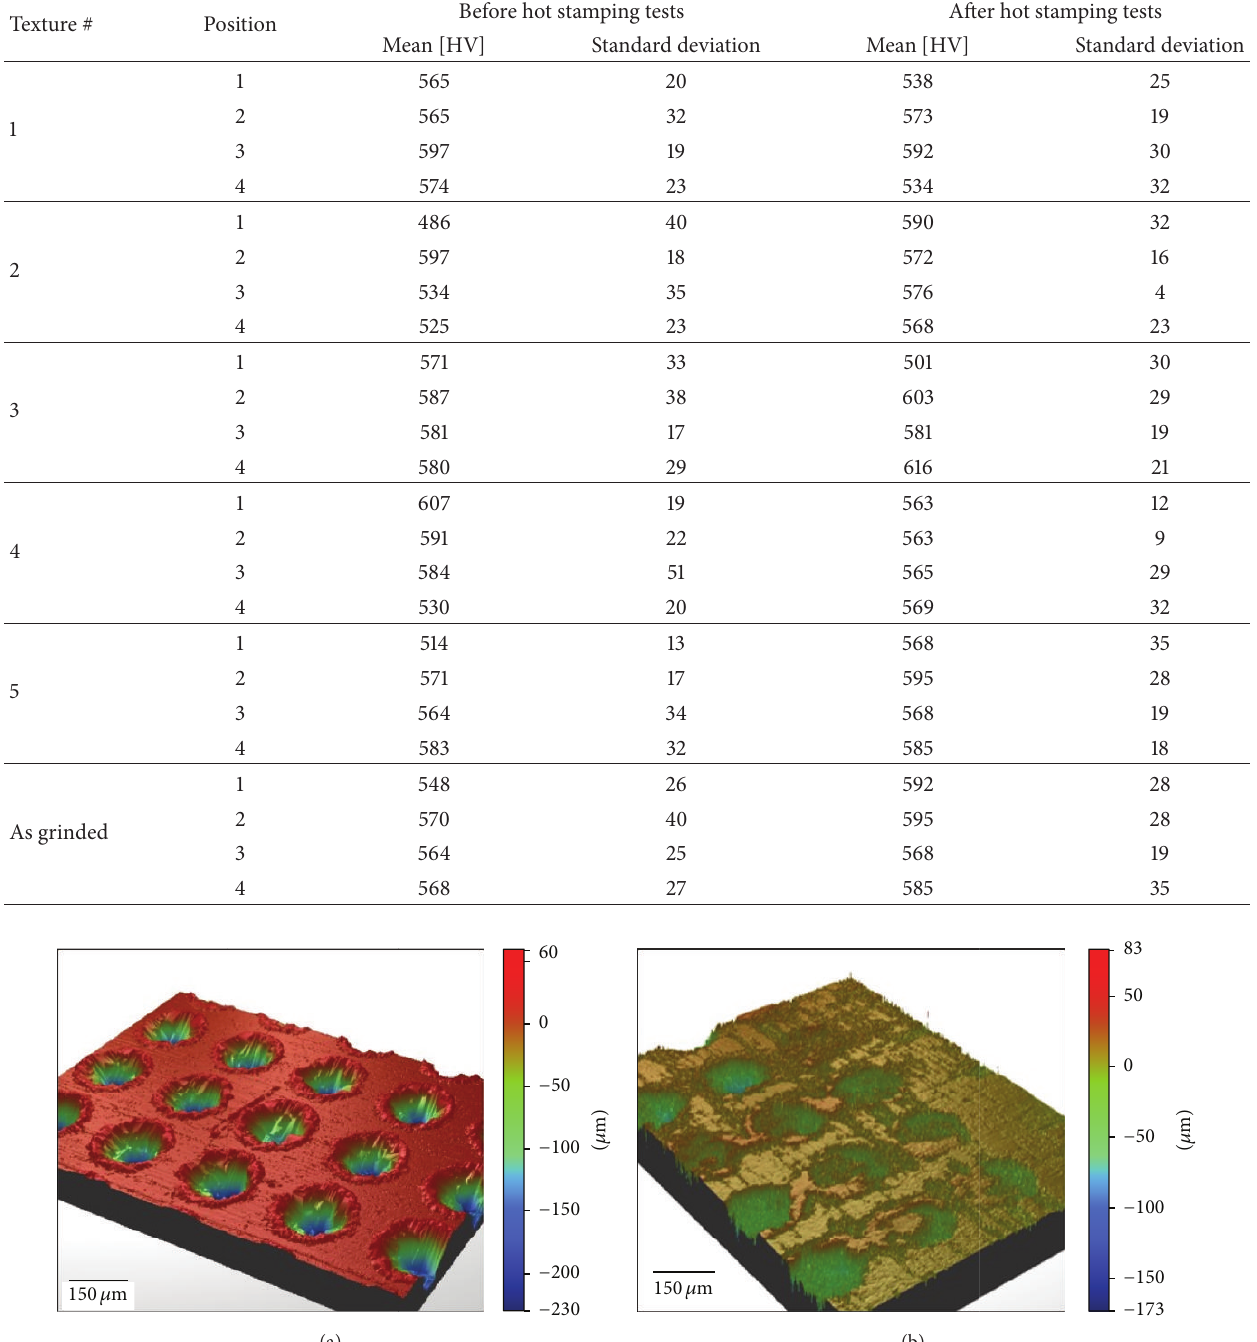
Figure 8: Surface topography—texture #2, die radius: (a) before and (b) after the stamping